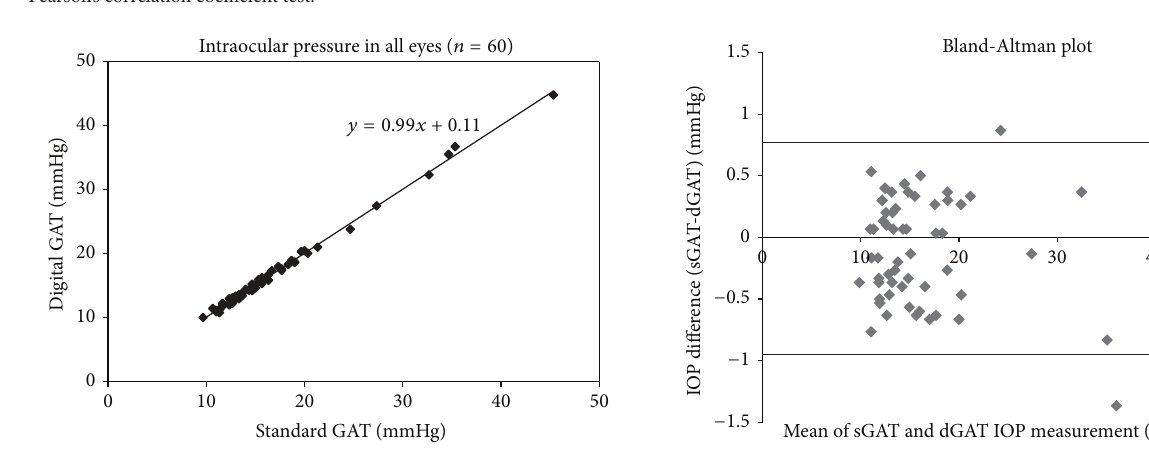
Figure 2: Scatter plot of intraocular pressure as measured by standard Goldmann applanation tonometry (GAT) and digital GAT. Standard and digital GAT measurements of intraocular pressure were positively correlated ( 𝑟 = 0.998 , 𝑃 < 0.01 , Pearson’s correlation analysis).